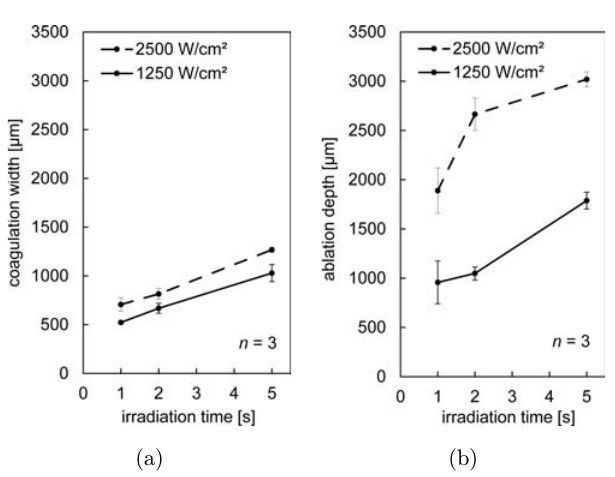
Fig. 7. Relationship between CO 2 laser irradiation time and (a) coagulation width and (b) ablation depth.